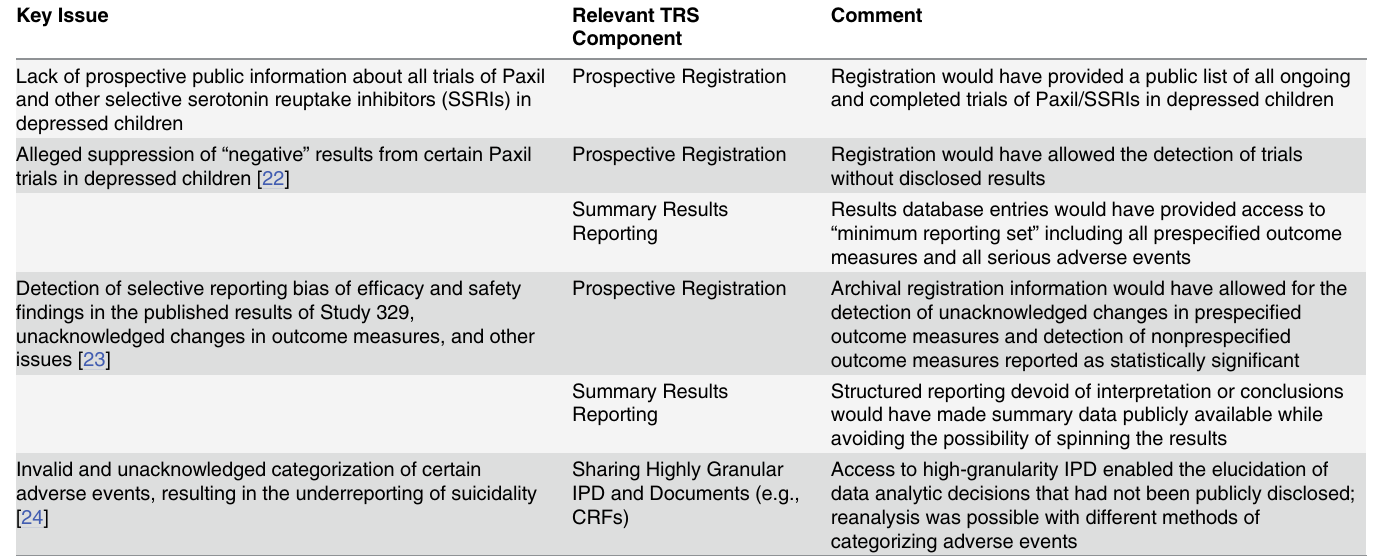
Table 1. Key issues with trials of antidepressant use in children for depression and the role of the TRS. Key